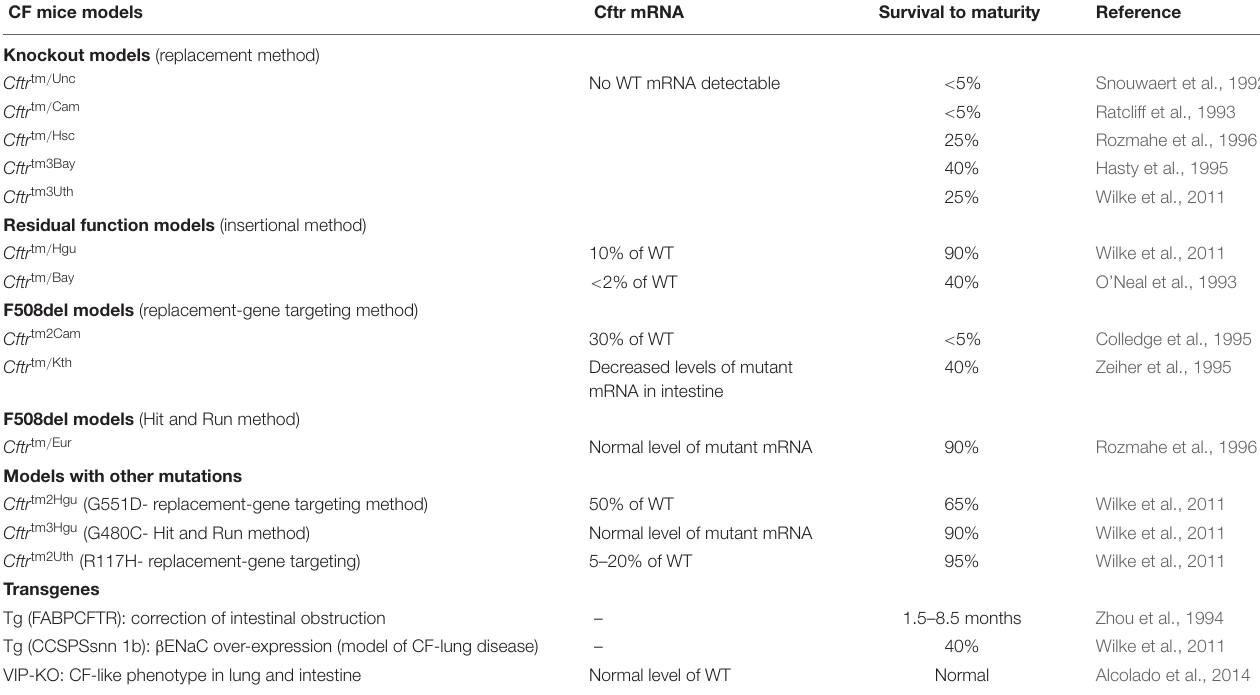
TABLE 2 | Murine models used in cystic fibrosis